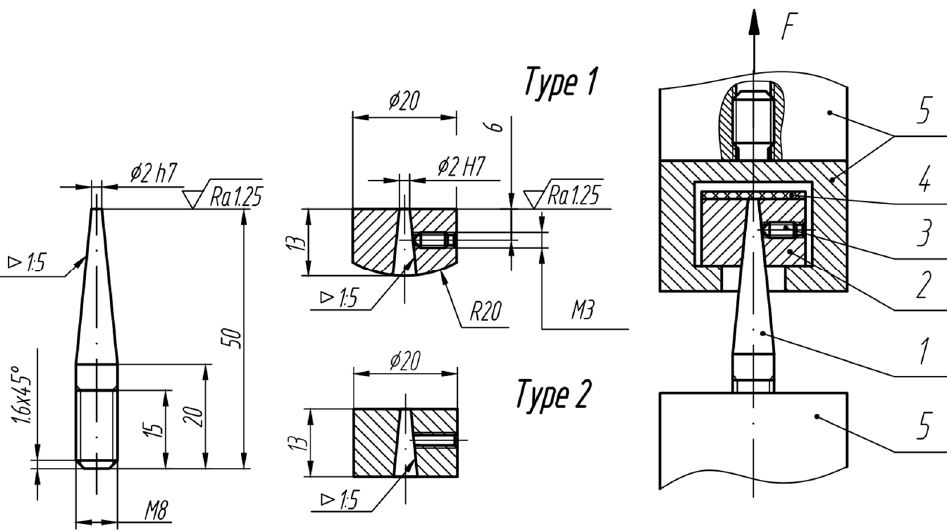
Figure 1. A conical pin specimen and self-aligned test fixture for tensile adhesion test: ( 1 ) Conical pin; ( 2 ) Matrix; ( 3 ) Centring screw; ( 4 ) Coating; ( 5 ) Equipment for tensile testing machine: F ─ ultimate tensile force.